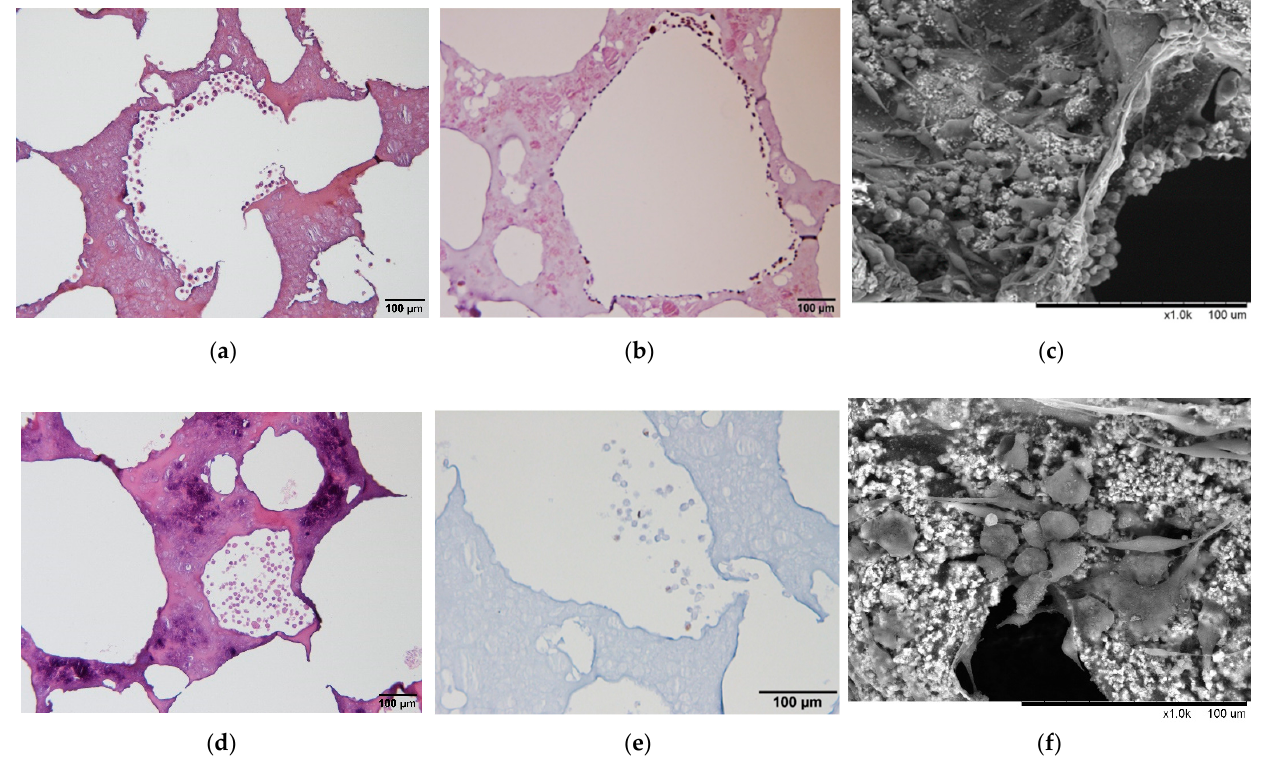
Figure 5. Proliferation of MDA-MB-231 dynamic culture on the seventh day. The ( a ) HE, ( b ) Ki-67, and ( c ) SEM were used, showing the cell proliferative state on the GHG scaffold; if EGF was immobilized on the scaffold massive cell proliferation was revealed, as presented by ( d ) HE, ( e ) Ki-67, and ( f ) SEM. The results indicate that EGF immobilized on the scaffold contributed to the proliferation of MDA-MB-231. (Scale bar: 100 µm) (The “×” in scale bar in the figure represents magnification).